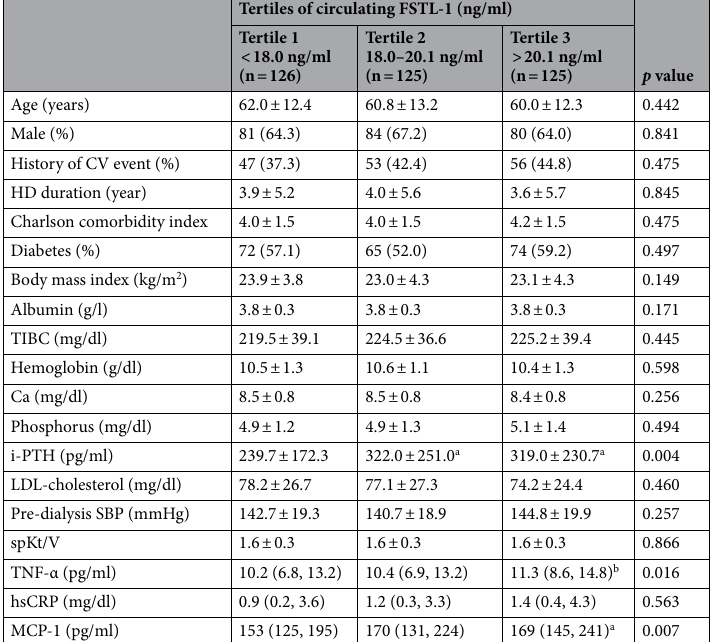
Table 1. Baseline demographic and laboratory data of the study population. Data are expressed as mean ± SD or median (interquartile range). TNF-α and MCP-1 were measured in 280 (74.5%) patients. FSTL-1 follistatin- like protein-1, CV cardiovascular, HD hemodialysis, Ca calcium, TIBC total iron binding capacity, i-PTH intact parathyroid hormone, LDL-cholesterol low-density lipoprotein cholesterol, SBP systolic blood pressure, spKt/V single-pool Kt/V, TNF-α tumor necrosis factor-α, hsCRP high-sensitivity C-reactive protein, MCP-1 monocyte chemoattractant protein-1. a p < 0.05 vs. textile 1. b p < 0.05 vs. tertile